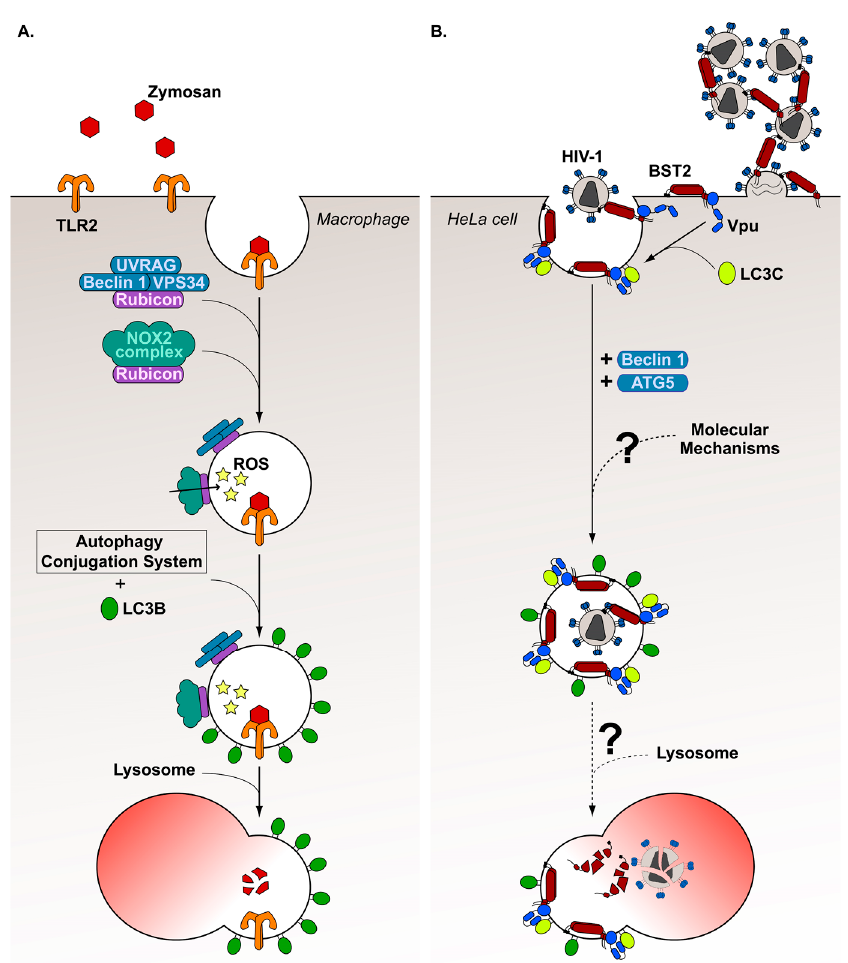
Figure 3. Comparative overview of LC3-Associated Phagocytosis (LAP)- and LC3C-dependent Vpu-mediated BST2 antagonism mechanisms. ( A ) Following its engagement with Toll-like receptor 2 (TLR2), zymosan is internalized by phagocytosis in macrophages. Subsequently, a PI3K complex composed of Rubicon, VPS34, Beclin 1 and UV radiation resistance-associated gene (UVRAG) proteins is recruited to the delimiting membrane of the phagosome resulting in a local production of phosphatidylinositol-3-phosphate (PI(3)P). This latter promotes recruitment of the NADPH oxidase-2 (NOX2) complex, which is responsible for reactive oxygen species (ROS) production into the phagosome. ROS, as along with the autophagy conjugation system, leads to decoration of the phagosome with LC3B, accelerating the phagosome-lysosome fusion process. ( B ) Following its interaction with the BST2 transmembrane domain at plasma membrane, Vpu recruits the LC3C protein to enhance internalization of BST2 into intracellular compartments, which are decorated with LC3 orthologs. This process requires Beclin 1 and ATG5 but not components of the preinitiation complex of autophagy (ULK1 and FIP200), which is reminiscent of the LAP mechanism, and results in the removal of BST2 from virus budding sites. However, the precise mechanisms by which this intracellular compartment is formed and the fate of this compartment within the cell are not yet determined.